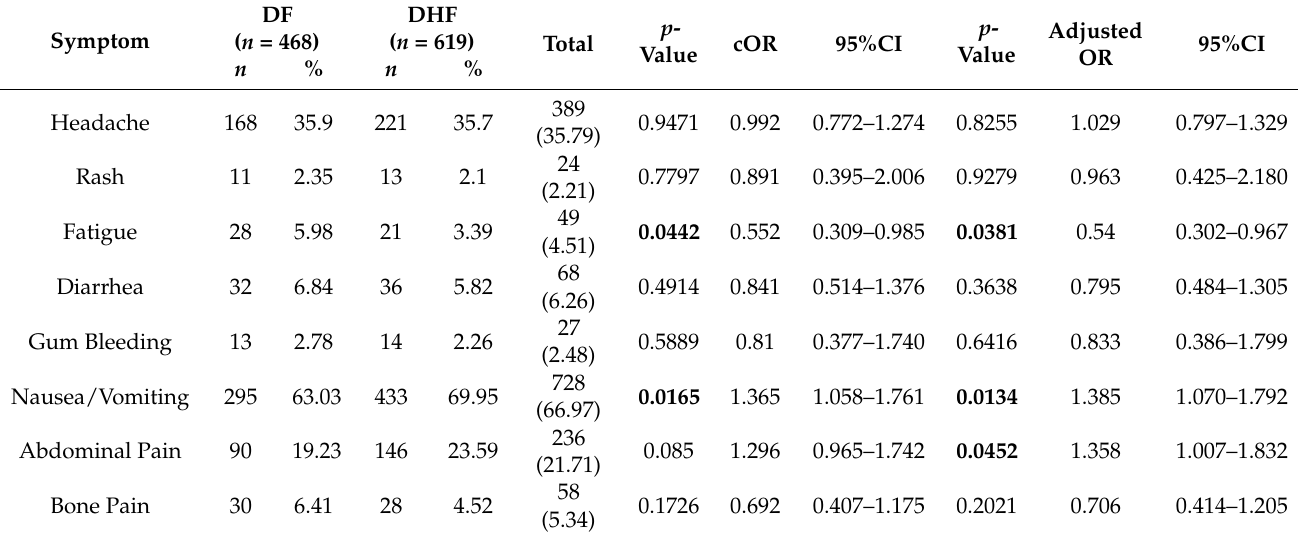
Table 2. Different Clinical Signs and Symptoms of Dengue